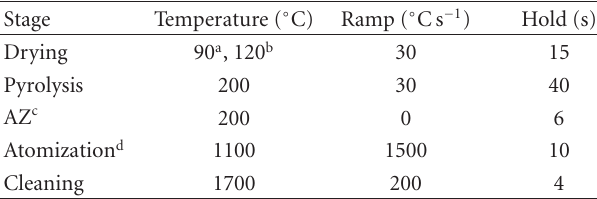
Table 1: Temperature program for the determination of